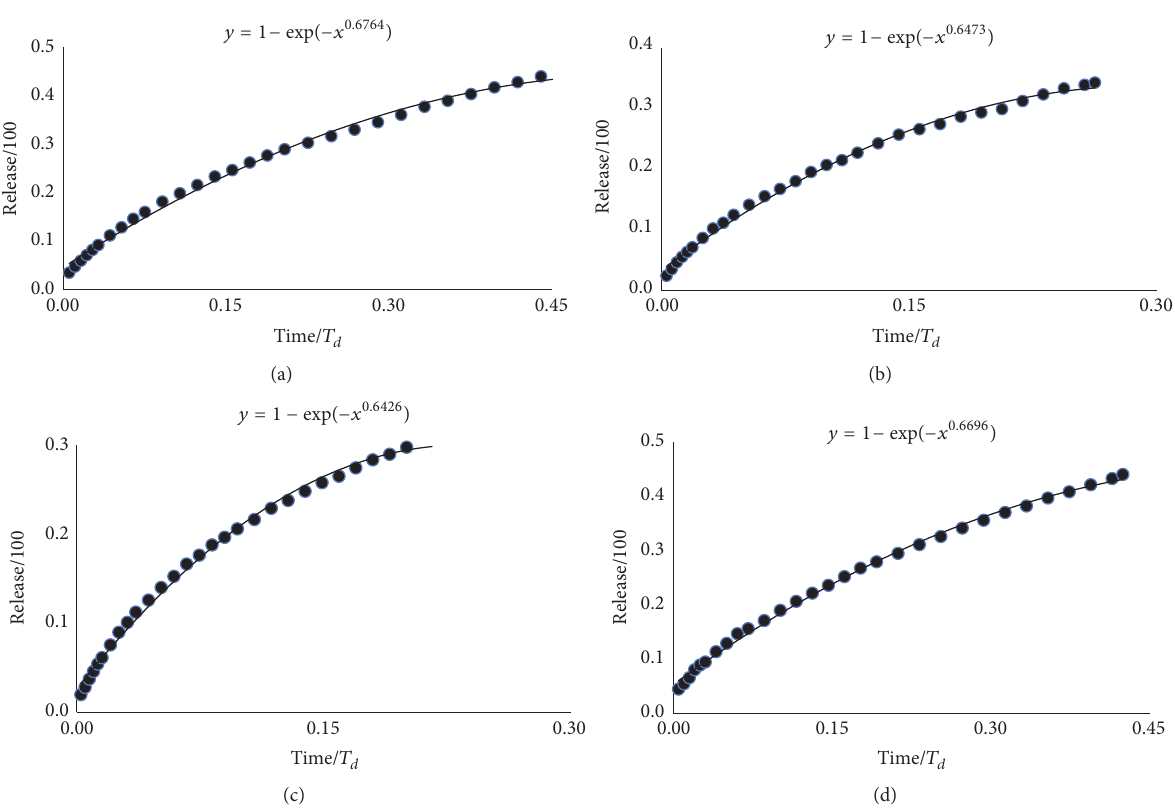
half-release time of EH was 8.47 ⋅ 10 2 min and the